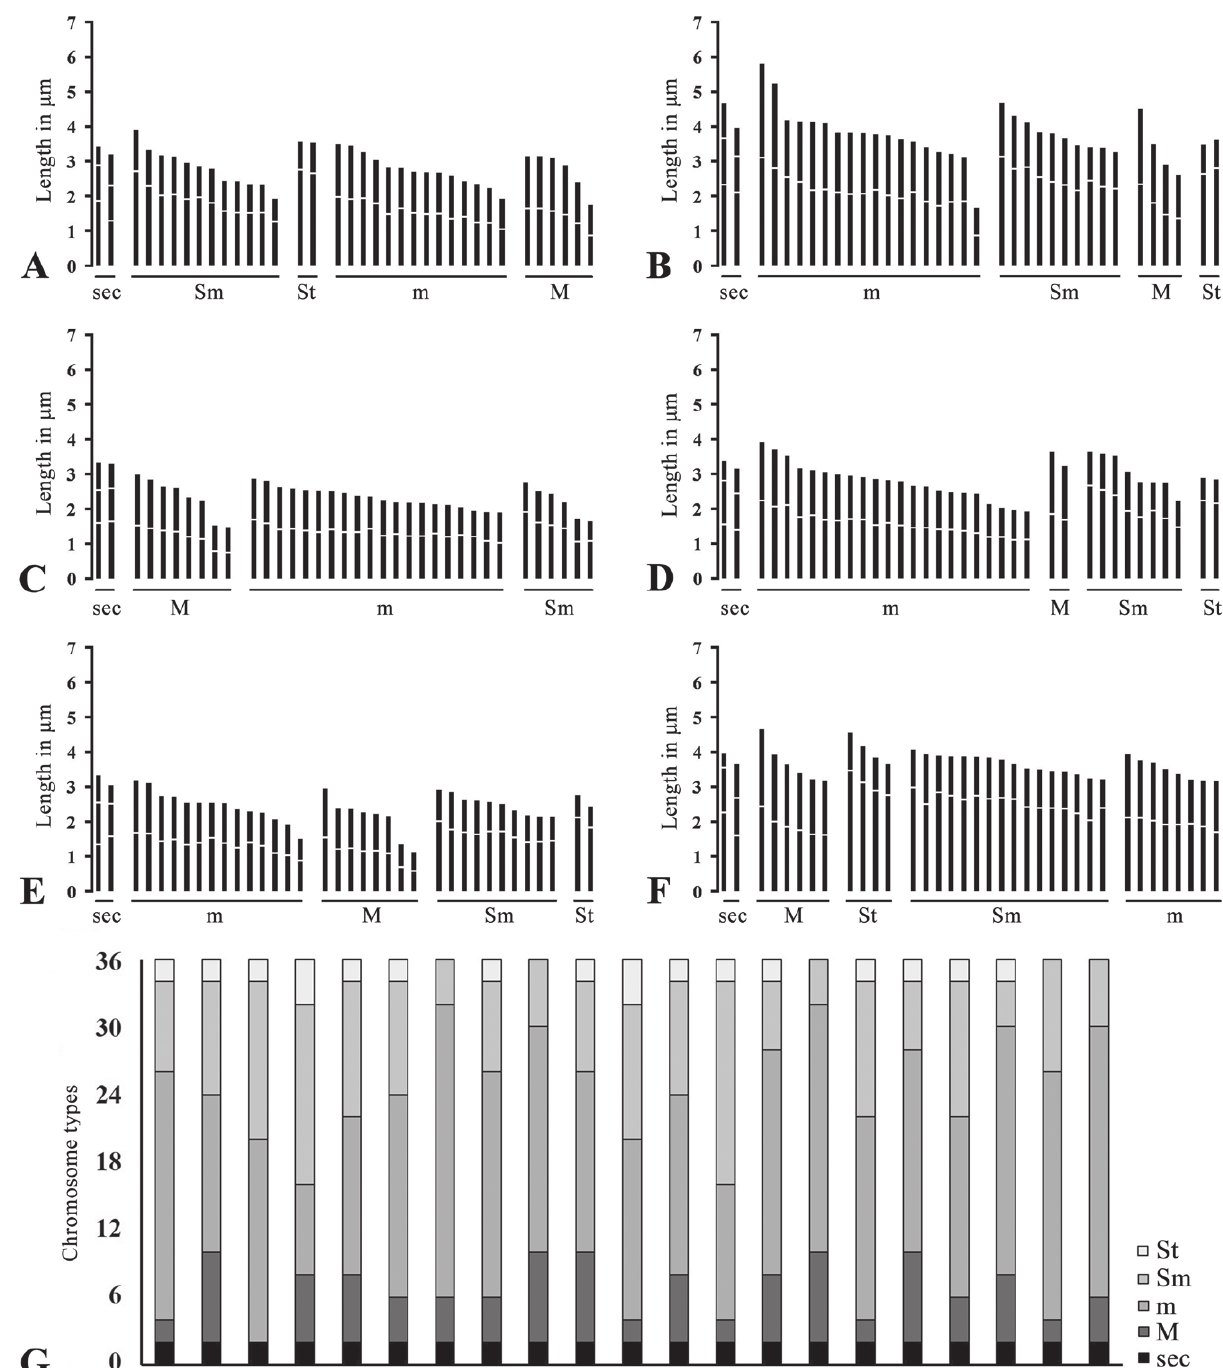
Figure 3. Idiograms of some cultivars of Chenopodium quinoa : (A) RD14 (B) RD31 (C) RD56 (D) BL71 (E) BL72 (F) BL–X3 (G) Com- parative graphical representation of distribution of constriction types in the cultivars of Chenopodium quinoa (M= median constriction, m= nearly median constriction, Sm= sub–median constriction, St= sub–terminal constriction, sec= secondary